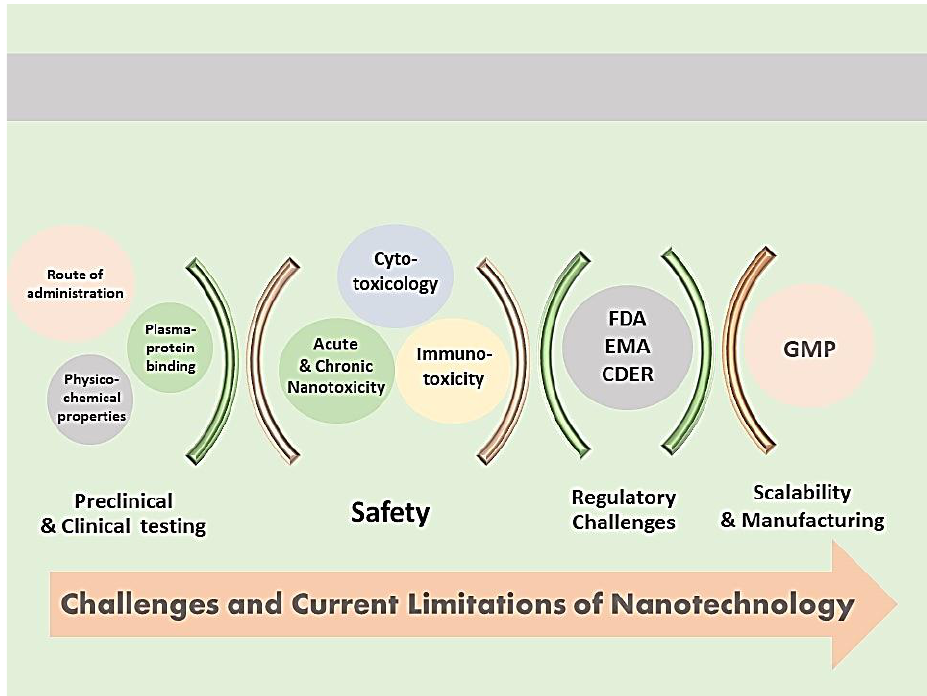
Figure 5. Pharmaceutical nanotechnology challenges and current Limitations. FDA — Food and Drug Administration; EMA — European Medicines Agency; CDER — Center for Drug Evaluation and Research; GMP — Good Manufacturing Practices.